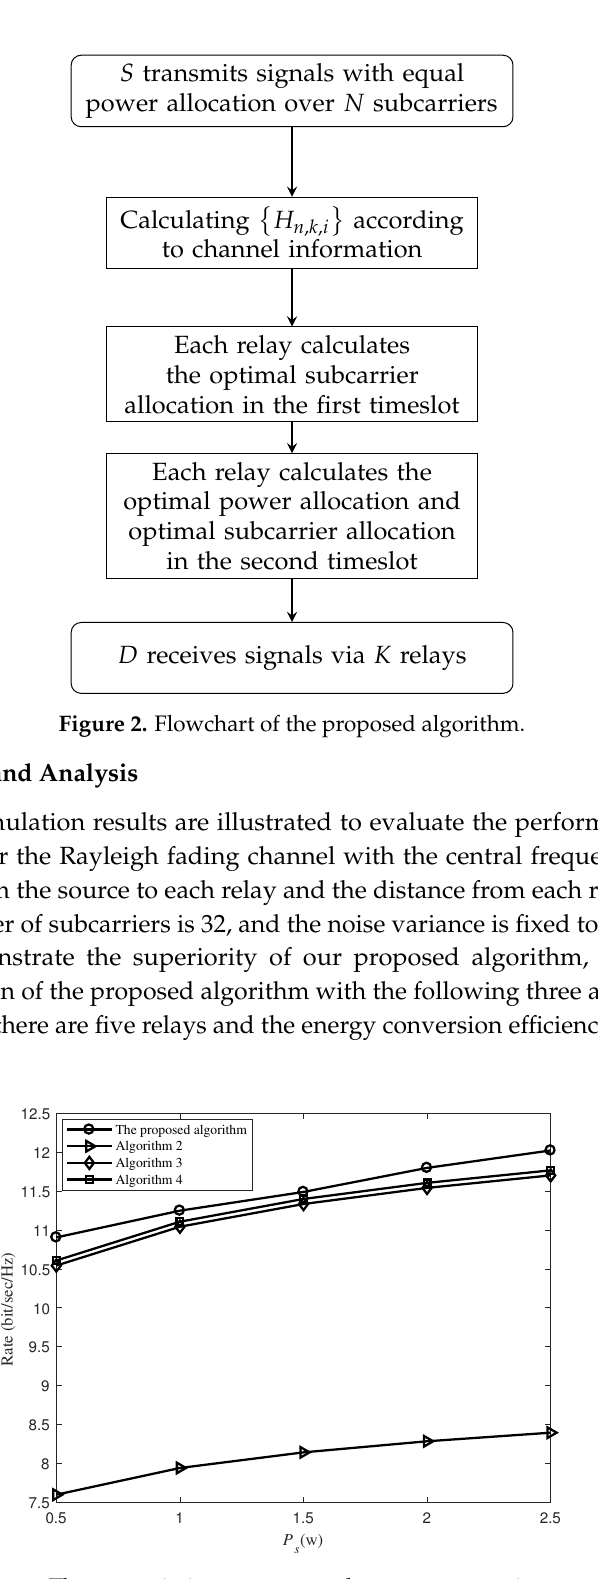
Figure 3. The transmission rate versus the source transmit power P s